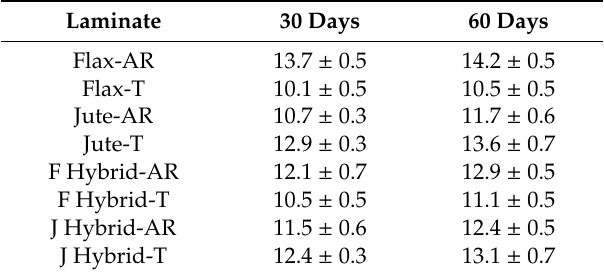
Table 6. Water absorption percentage of all laminates in each aging